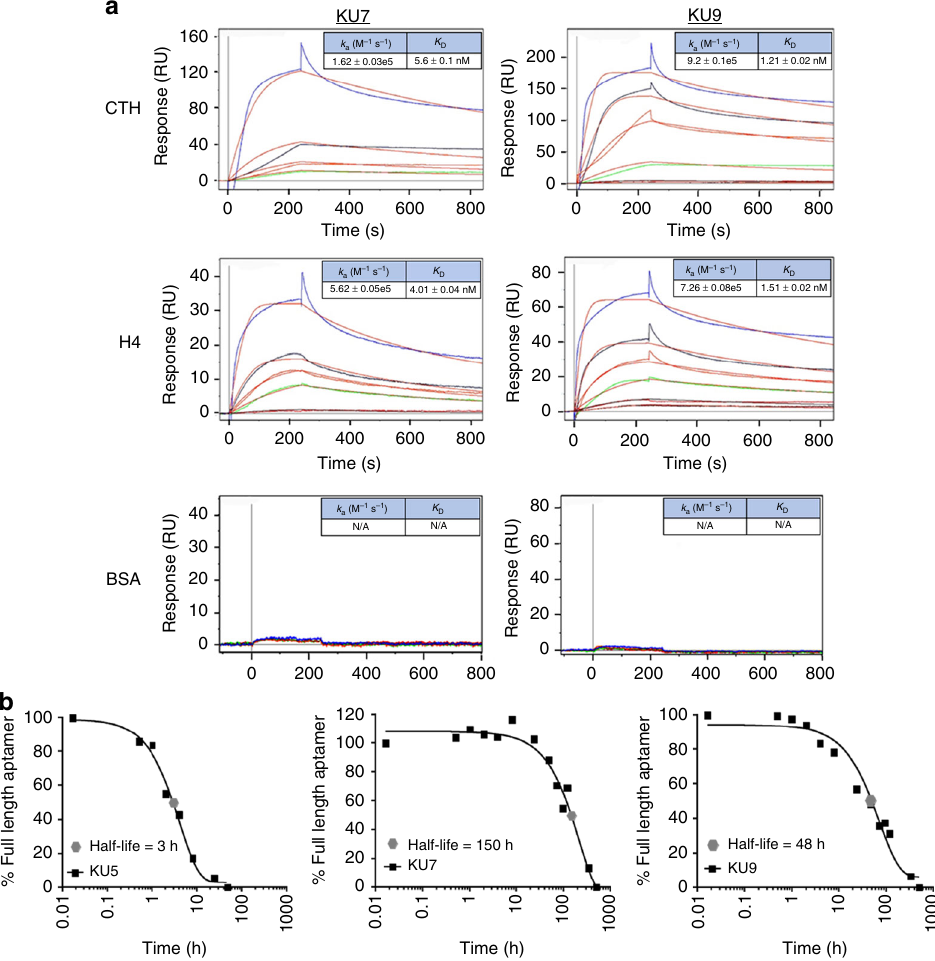
Fig. 2 Binding characterization and stability measurements of individual histone RNA aptamer sequences. a Binding kinetic rate constants ( k a and K D ) determined for aptamers KU7 (left panels) and KU9 (right panels) binding to CTH (top panels), H4 (middle panels) and BSA (bottom panels). Aptamers concentrations tested: 100 nM (blue), 50 nM (black), 25 nM (red), 12.5 nM (green), 10 nM (magenta). b Serum stability measurements for aptamers